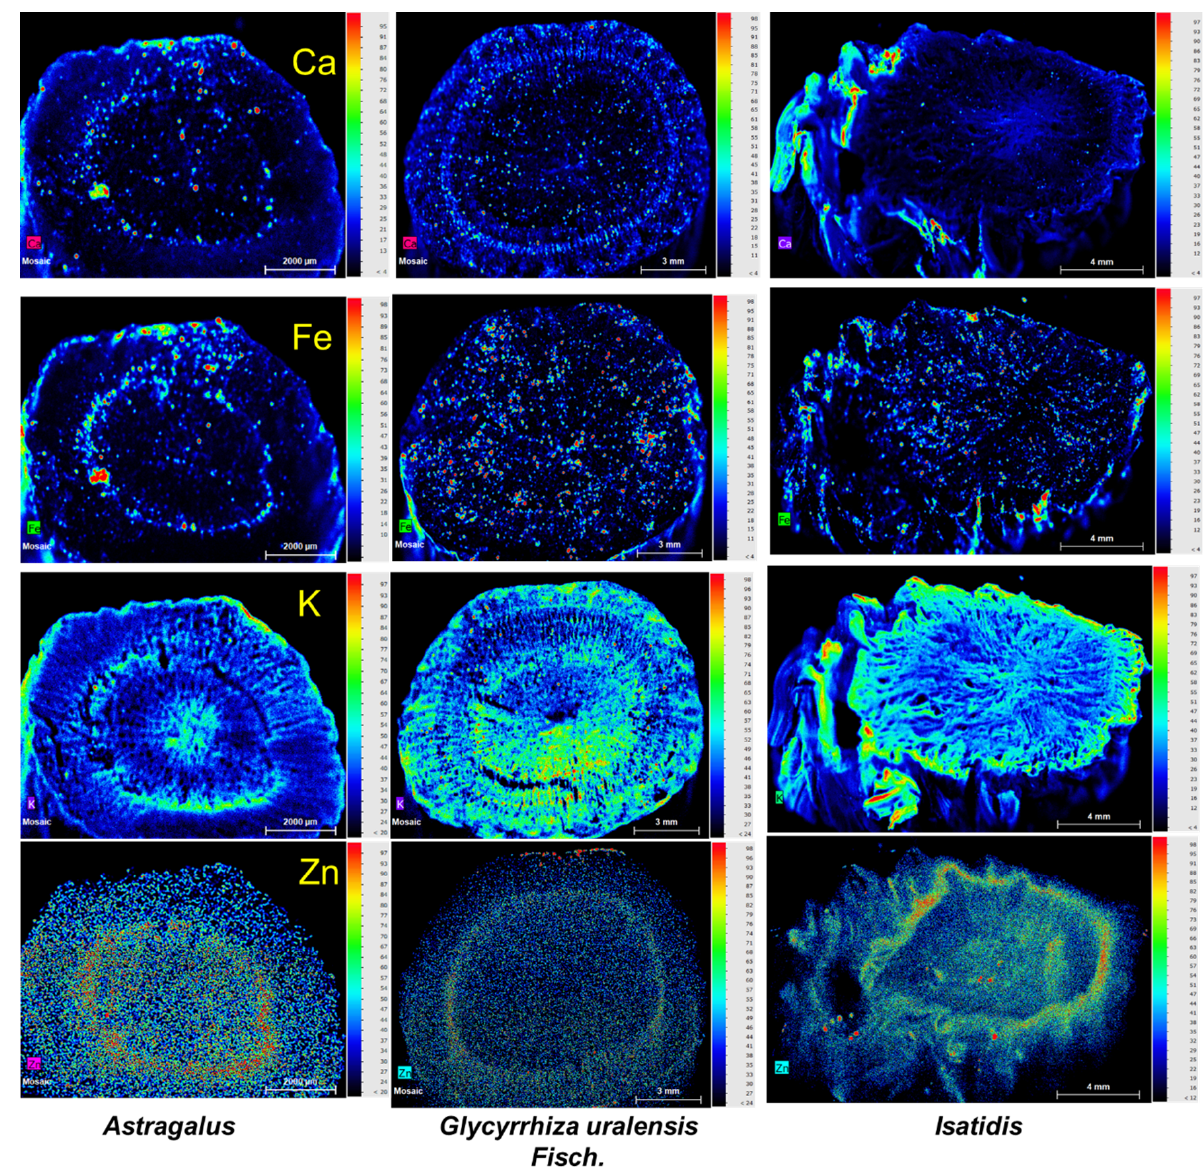
Figure 6. Distribution of Ca, Fe, K, and Zn on the three experimental herbal medicines, imaged using a µ -XRF spectrometer. Normalized X-ray fluorescence intensities are scaled from red (maximum) to blue (minimum) as indicated at the right.